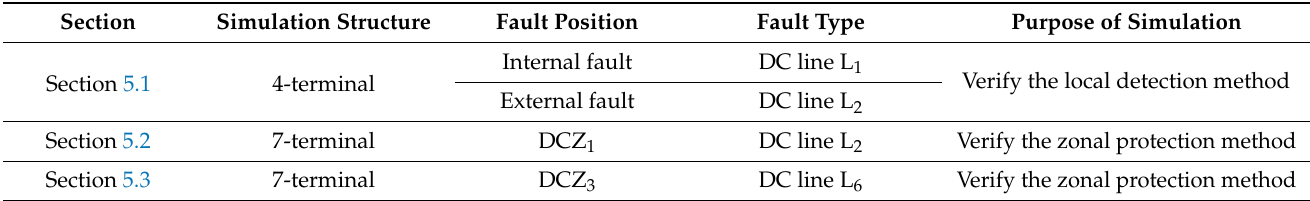
Table 4. Considered cases for the assumed